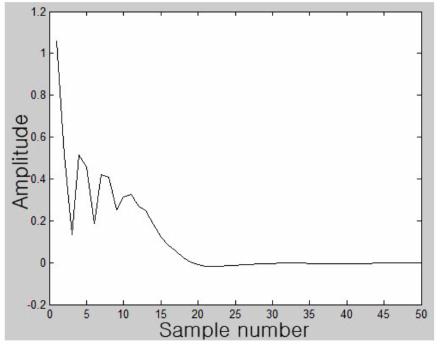
Figure 6. Signal with discrete cosine transform (DCT)